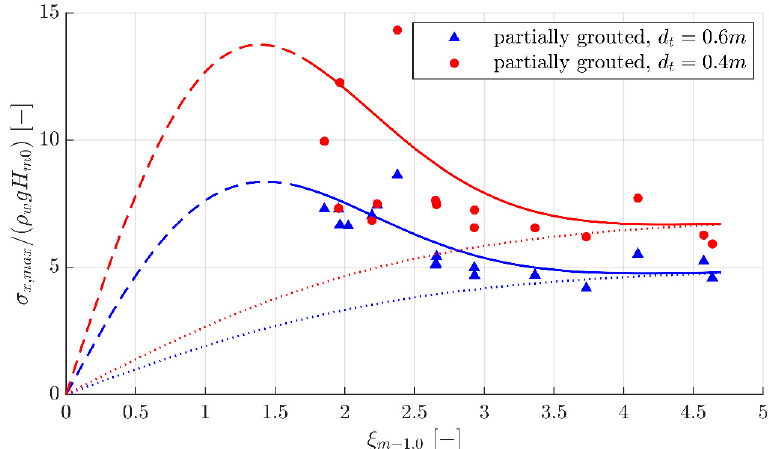
Figure 8. Maximum relative tensile bending stress σ x,max /( ρ w gH m 0 ) dependent on the surf similarity parameter ξ m − 1,0 with enveloping functions (permeable, partially grouted MGRRs, parameter combination 1). The quasi ‐ static component of the relative bending stress from Equation (9) is shown as a dotted line. The dashed line for illustration shows the enveloping functions for surf similarity parameters for which no experimental data is available (after [28]).